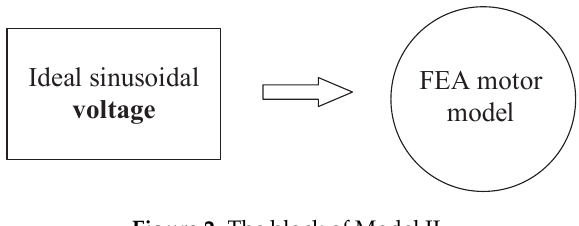
Figure 2. The block of Model